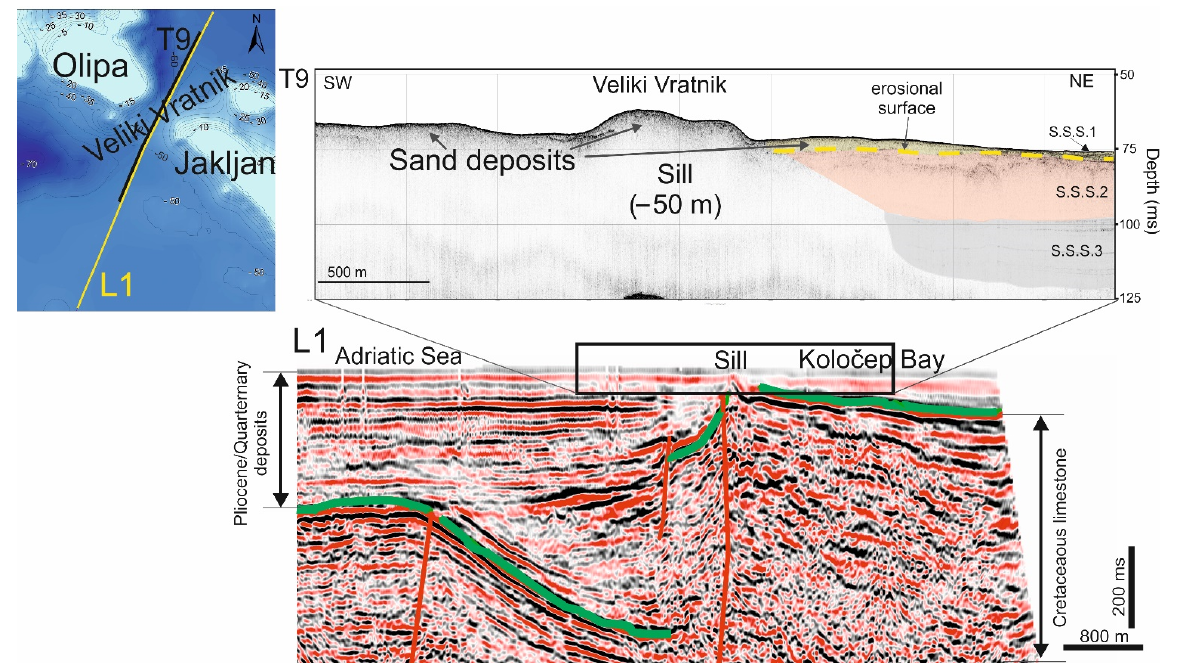
Figure 13. Interpreted seismic section 2D seismic profile L1 correlated with high-resolution seismic profile T9. On the profile L1, the red vertical lines represent reverse faults, and the green line represents the karstified Mesozoioc carbonate boundary. The T9 profile shows the depositions of aeolian sand, which are blown from the Albanian shelf, and sill, which is covered with deposits of sand.